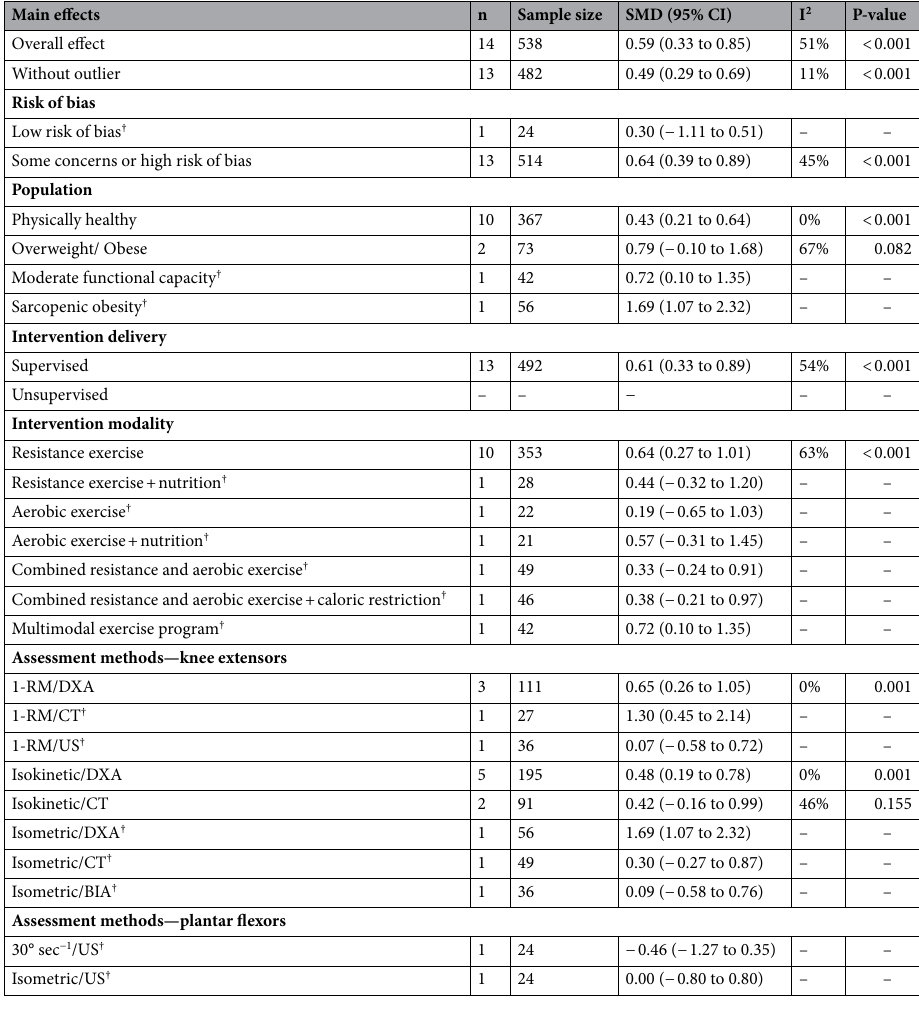
Table 3. Overall and subgroup exercise effects on MQ derived from neuromuscular outcomes in older adults. † Insufficient data for analysis, BIA, Bioelectrical impedance analysis; CT, computed tomography; DXA, dual-energy X-ray absorptiometry; I 2 , indicator of between-study heterogeneity; n, number of studies; SMD, standardised mean difference; US, muscle